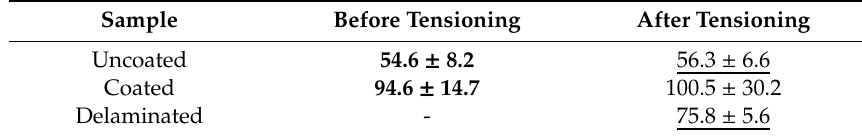
Table 3. Root mean square roughness, R s (nm), corresponding to uncoated and Ag-coated samples before and after tensile test. All the reported values were extracted from 20 × 20 µ m 2 images.